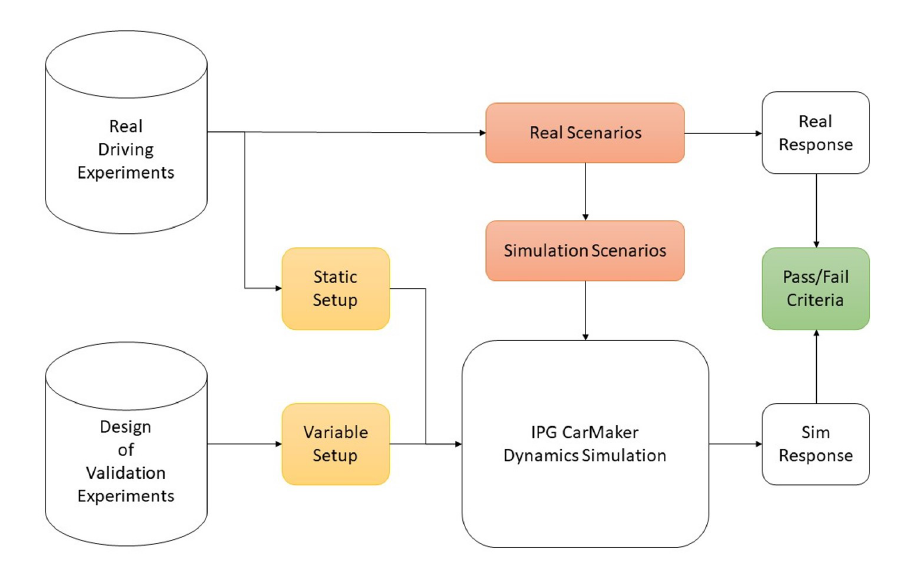
Figure 2. IPG CarMaker vehicle dynamics simulation model validation